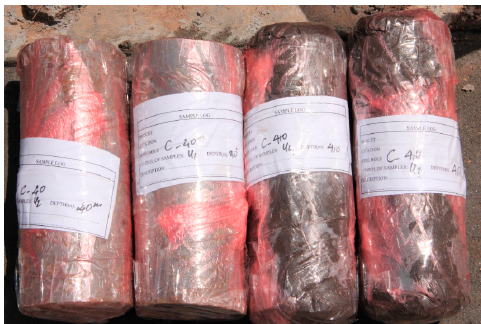
Figure 2. Undisturbed samples.